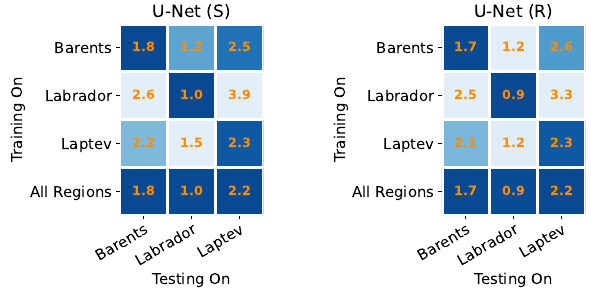
Figure 10. Improvement of JAXA SIC MAE (in percentage points, higher is better) for general U-Net (R) with GFS over regional U-Net (R) with GFS for different months of 2021 and different days of the forecast. The matrix for each region and subfigure is color-coded independently in a red-blue scheme to provide a better perception of the relative improvement for each month and forecast day in the corresponding region. The numbers in each cell are rounded and should be used to estimate the overall improvement scale in the regions. Improvement is computed in absolute percentage points and tends to be higher for months with active sea ice change.